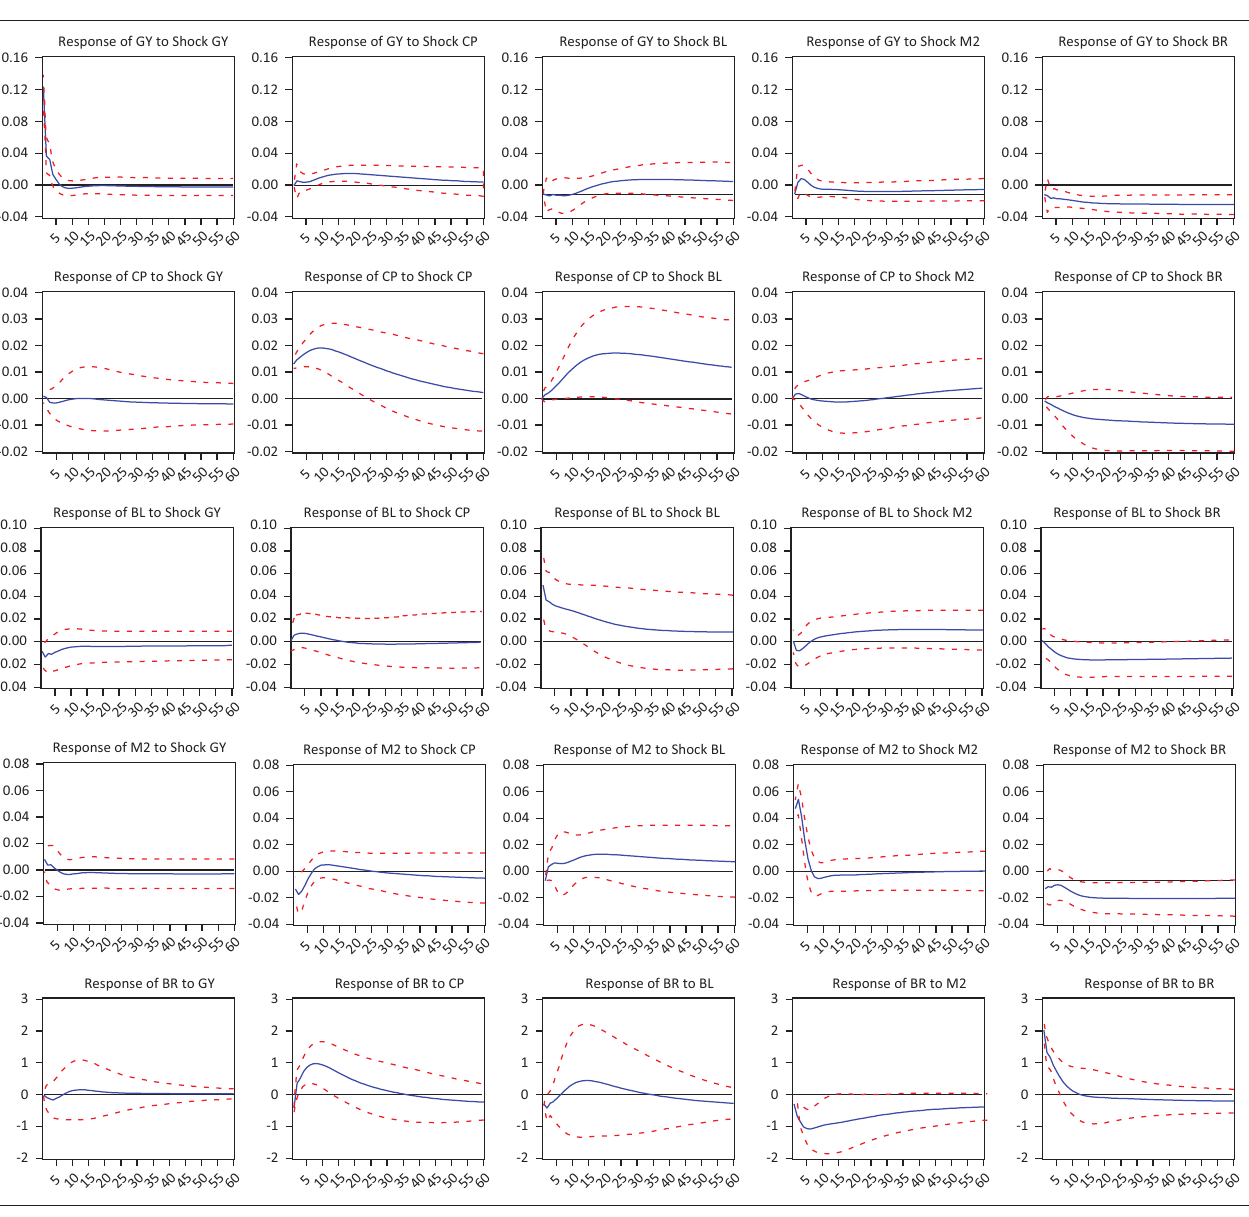
FIGURE 1-A1: Impulse responses with formal financial sector data